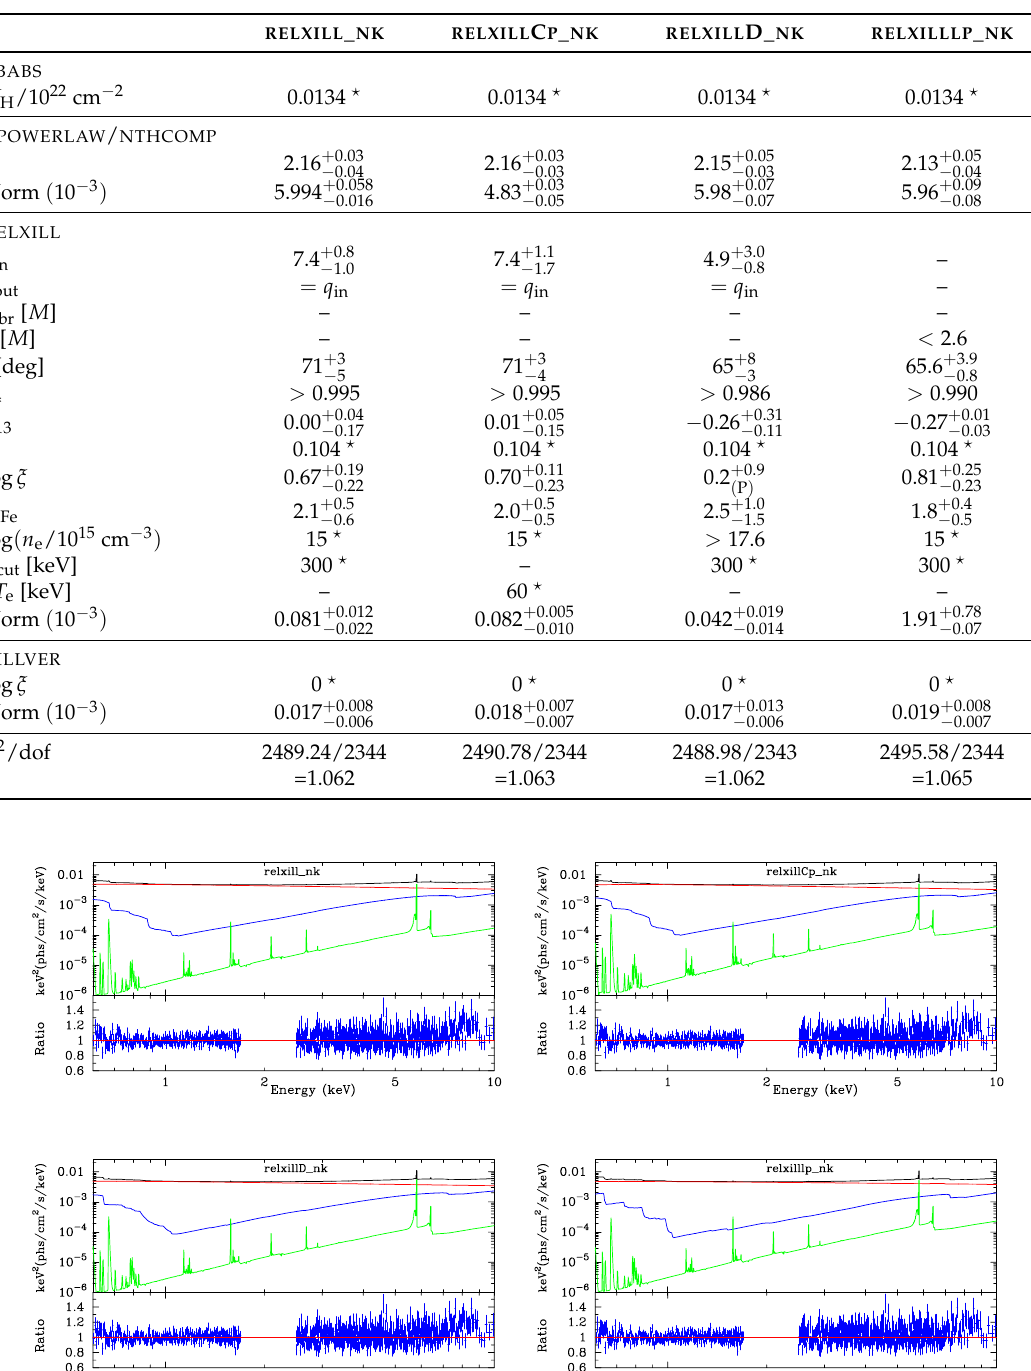
Table A3. Summary of the best-fit values for the supermassive black hole in 1H0419–577. (cid:63) indicates that the parameter is frozen to that value in the fit.